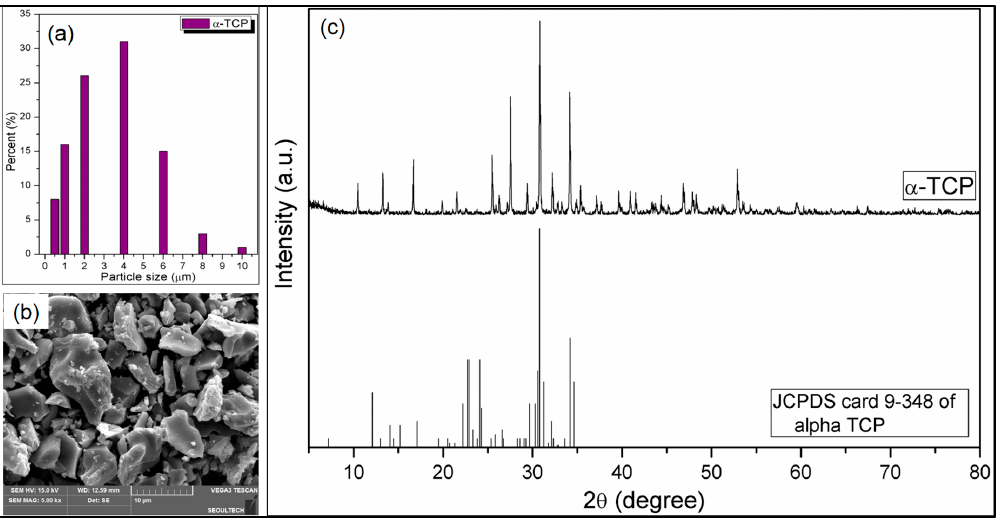
Figure 2. ( a ) Size distributions of the synthesized α -TCP particles obtained from laser diffraction micro-particle size analyzer; ( b ) Scanning electron microscopy (SEM) image of the synthesized α -TCP particles; ( c ) X-ray diffraction (XRD) spectra of the synthesized α -TCP particles and JCPDS card 9-348 of alpha TCP.